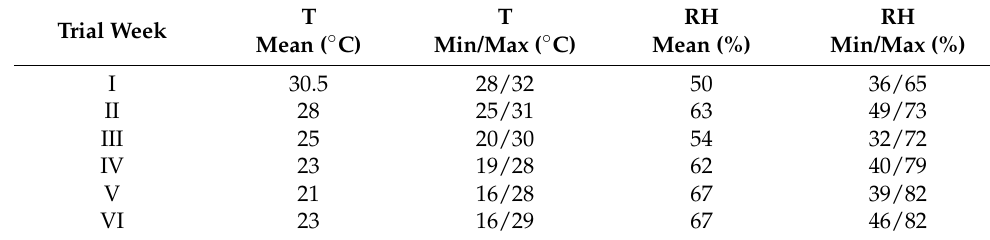
Table 1. Weekly averages of ambient temperature (T) and relative humidity (RH) during the